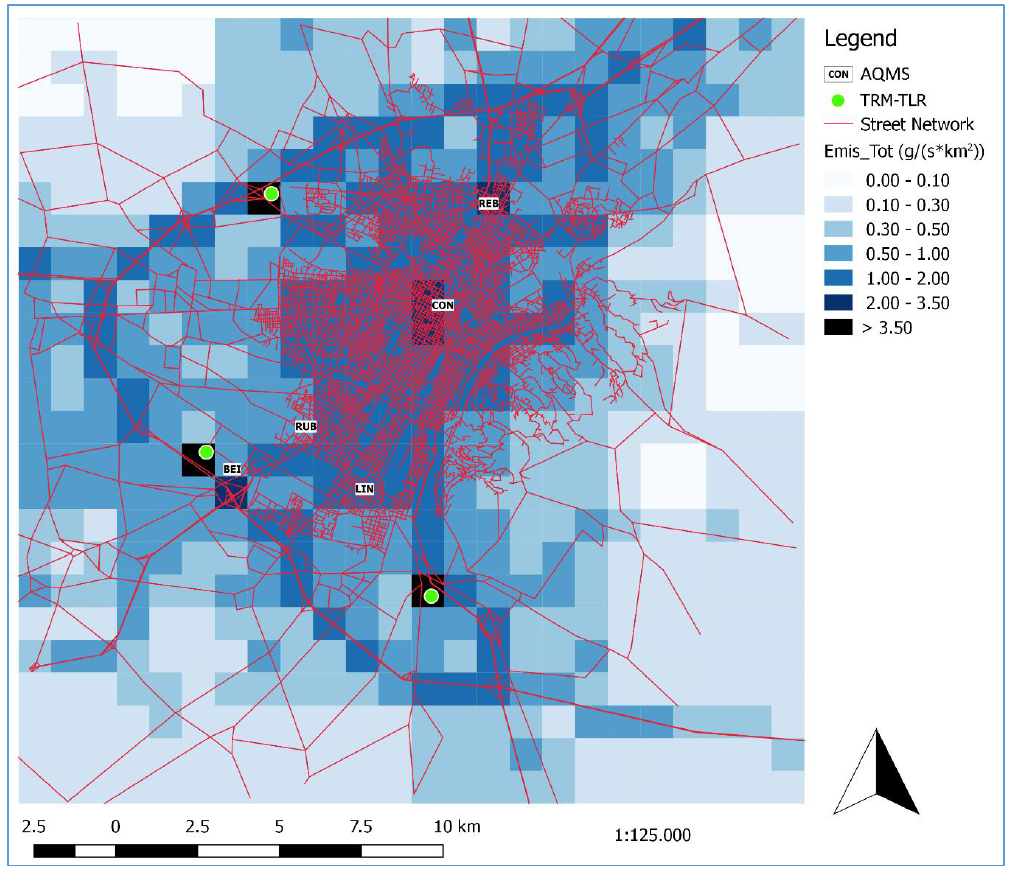
Figure 4. Map of the simulation domain with AQMS locations, TRM and TLR plants, street network and total annual NO X emissions normalised per square kilometre (g/(s × km 2 )) (elaboration by means of QGIS 2.18).